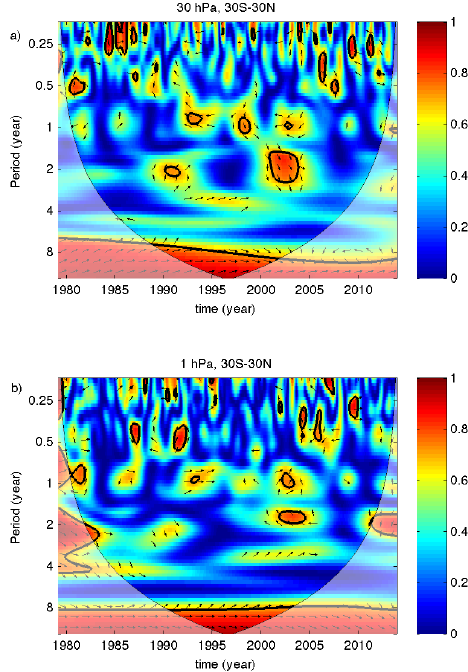
Figure 9. As in Fig. 8 but for the input signals T and Mg II index: (a) 30hPa, 30 ◦ S–30 ◦ N; (b) 1hPa, 30 ◦ S–30 ◦ N. Thick contours identify the 5% significance level against red noise, while arrows denote the phase between the two signals (in phase pointing east- ward and out of phase pointing westward). The cone of influence (COI) where edge effects might distort the picture is shown as a lighter